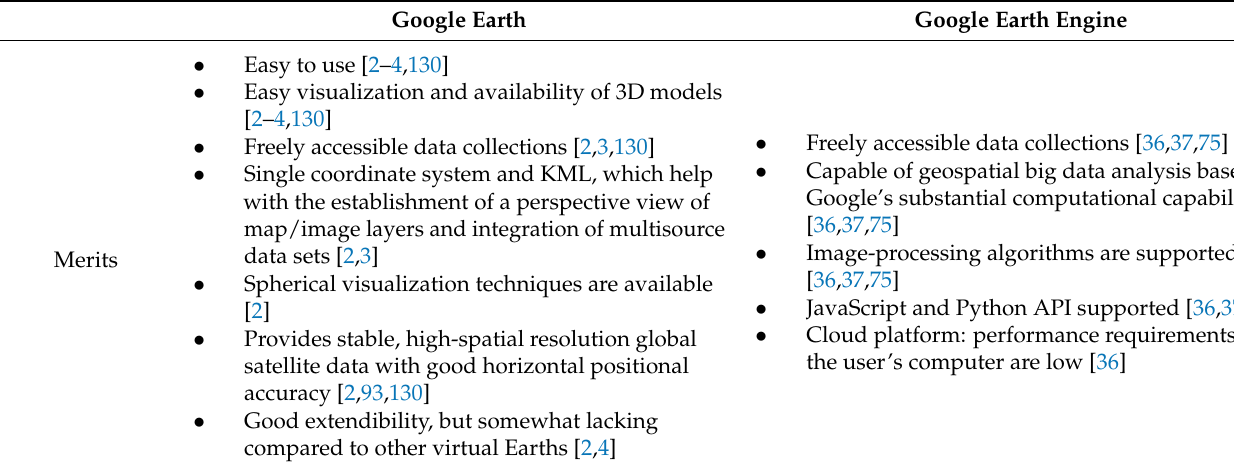
Table 4. Merits and limitations of GEE and